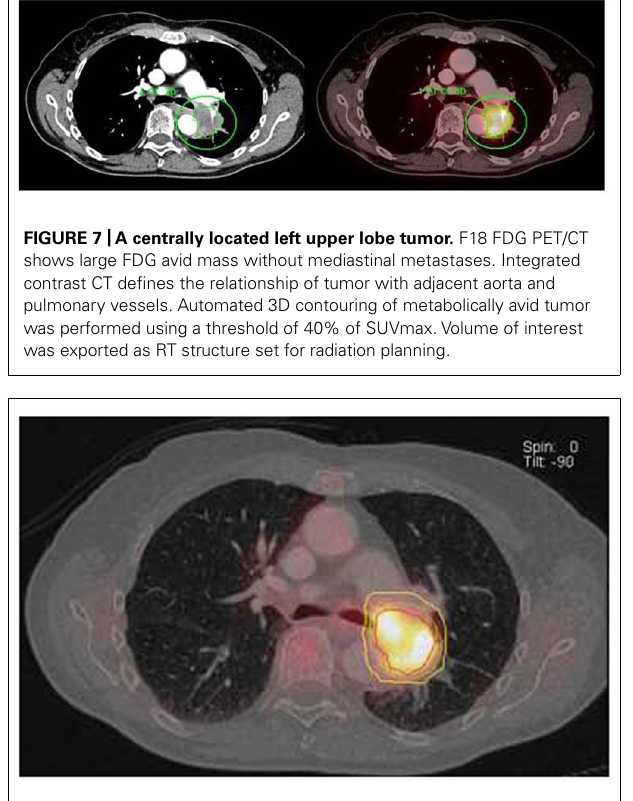
FIGURE 8 | GTV (red line) drawn based on 40% SUVmax threshold using an automated volume of interest (VOI) definition of metabolically tumor. Clinical target volume (green line) and planning target volume (yellow line) generated by adding 0.5 cm and 1 cm margin to the GTV. Data courtesy of Karolinska Institute